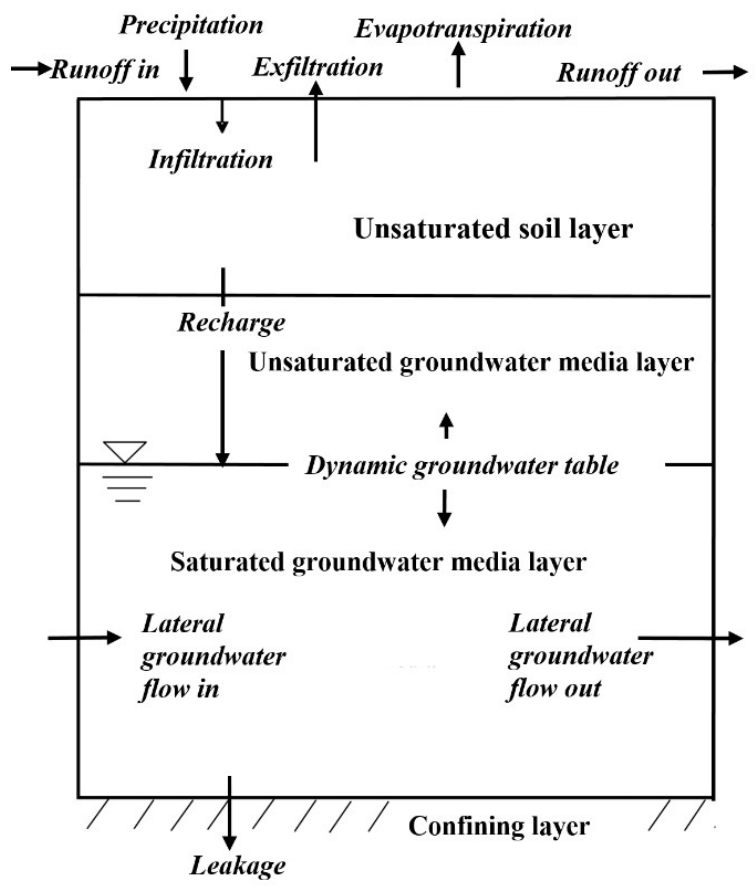
Figure 3. Linking surface water and ground water through soil moisture model.